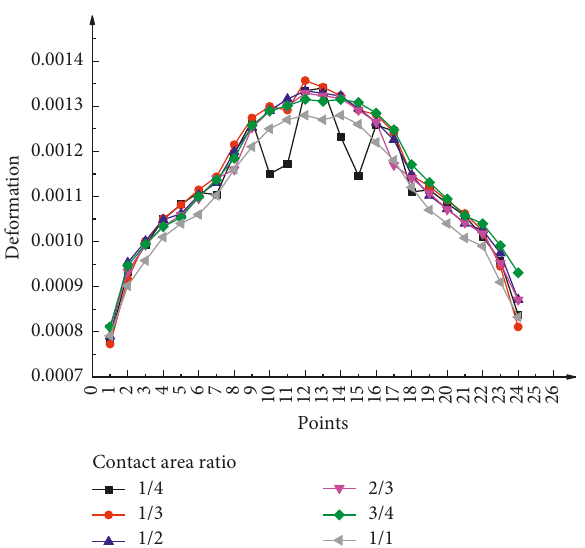
Figure 11: The deformation of various contact area ratios. The black curve represents the ratio of contact area of 1/4, the red curve represents the ratio of contact area of 1/3, the blue curve represents the ratio of contact area of 1/2, the pink curve represents the ratio of contact area of 2/3, the green curve represents the ratio of contact area of 3/4, and the gray curve represents complete contact.